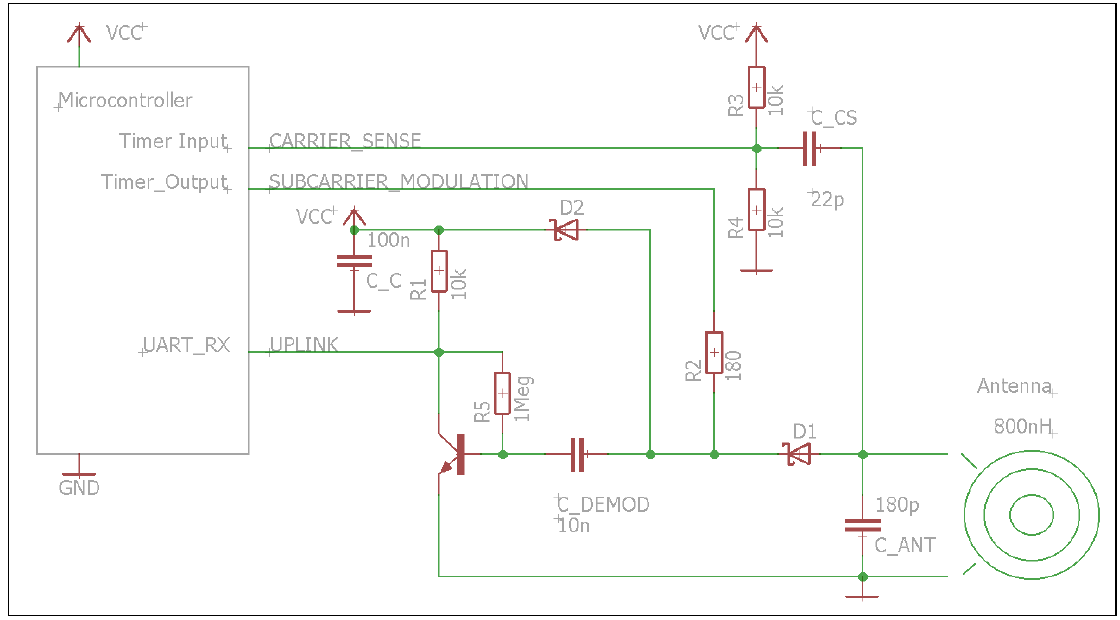
Figure 5. Schematic of the integrated RFID transponder. Only a few components are needed: Microcontroller, resonant antenna, a feed of the carrier into the microcontroller (C_CS), load modulator (R2), AM demodulator (D1), transistor amplifier, and supply voltage generator